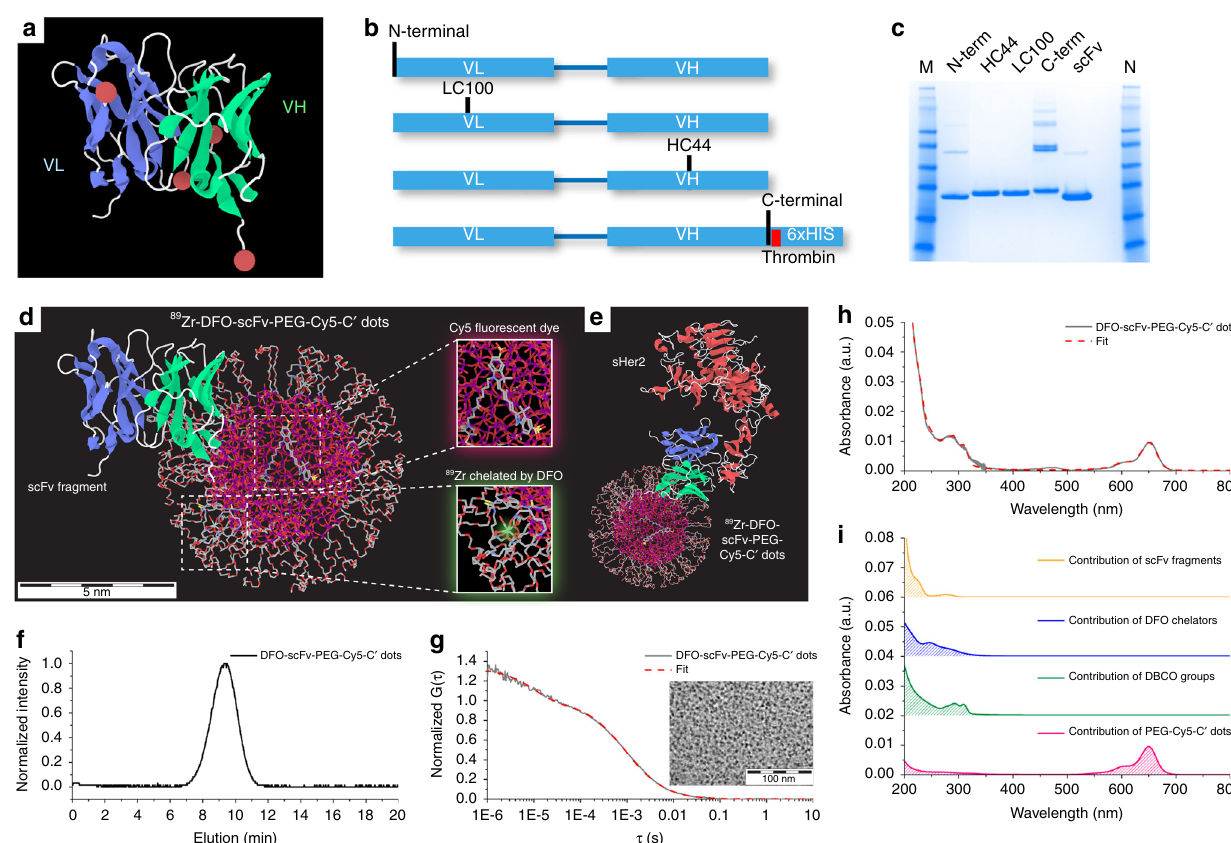
Fig. 1 Site-speci fi c engineering of anti-HER scFv fragments and synthesis of DFO-scFv-PEG-Cy5-C ’ dots. a Three-dimensional (3D) scFv model highlighting sites of conjugation (i.e., red balls). b Schematic representation of scFvs directed to HER2/neu extracellular domain with sites of nnAA integration indicated (N-terminal, LC100, HC44, and C-terminal). Sites were rationally designed to be distal to the antigen binding domains (blue ribbon) and surface-exposed to avoid functionally important domains. c Af fi nity puri fi ed scFvs containing a nnAA at the indicated positions by SDS-PAGE under non-reducing conditions; HC44 and LC100 constructs generated mostly unique bands. scFv constructs with N-terminal, and in particular with C-terminal, nnAA produced disul fi de-linked multimers observable as discrete bands of increasing molar mass. Unmodi fi ed scFv was resolved for comparison. d, e 3D rendering of 89 Zr-DFO-scFv-PEG-Cy5-C ’ dot ( d ) and 89 Zr-DFO-scFv-PEG-Cy5-C ’ dot bonded to sHER2 ( e ). The atoms of silicon, oxygen, carbon, nitrogen, sulfur, and zirconium in the 3D renderings are colored in purple, red, gray, blue, yellow, and light green, respectively. Hydrogen atoms are not displayed for better visualization. f – i GPC elugram ( f ), FCS correlation curve with fi t ( g ), and UV – vis absorbance spectrum with fi t ( h ) of DFO-scFv-PEG-Cy5-C ’ dots. i Deconvolution of the UV – vis spectrum ( h ) into contributions of individual functional moieties, including PEG-Cy5-C ’ dot (red), DBCO (green), DFO (blue), and scFv (orange). A representative TEM image of DFO-scFv-PEG-Cy5-C ’ dots is shown in the inset of